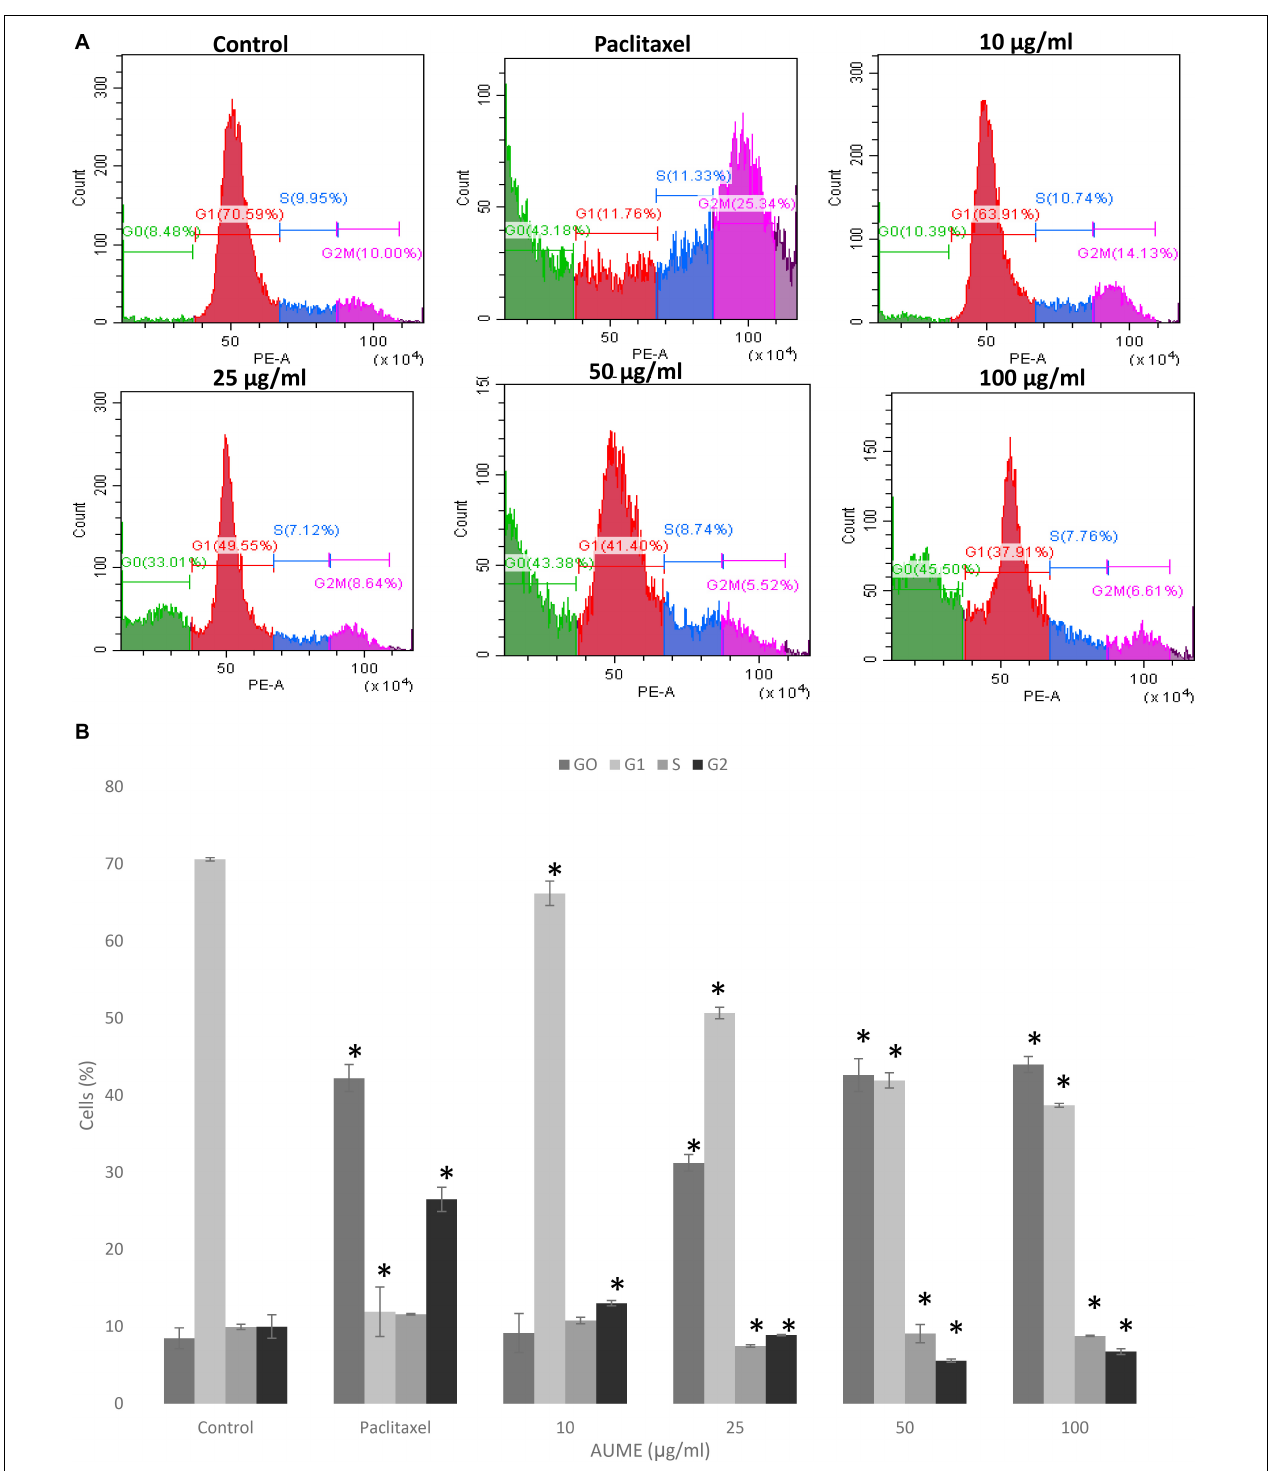
FIGURE 4 | (A) Flow cytometric analysis of HeLa cells treated with indicated concentration of AUME estimated using PI staining. There was an increase in the apoptotic Go phase in a dose-dependent manner. (B) The bar diagram represents the percentage of cells in each phase of cell cycle. Values are given as means ± SD of three replicates in each group, p < 0.05, *statistically significant when compared to control.